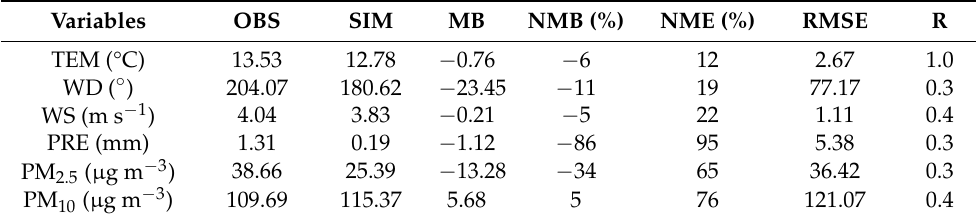
Table 2. Performance of the WRF-Chem model in simulations for meteorological variables and PM 10